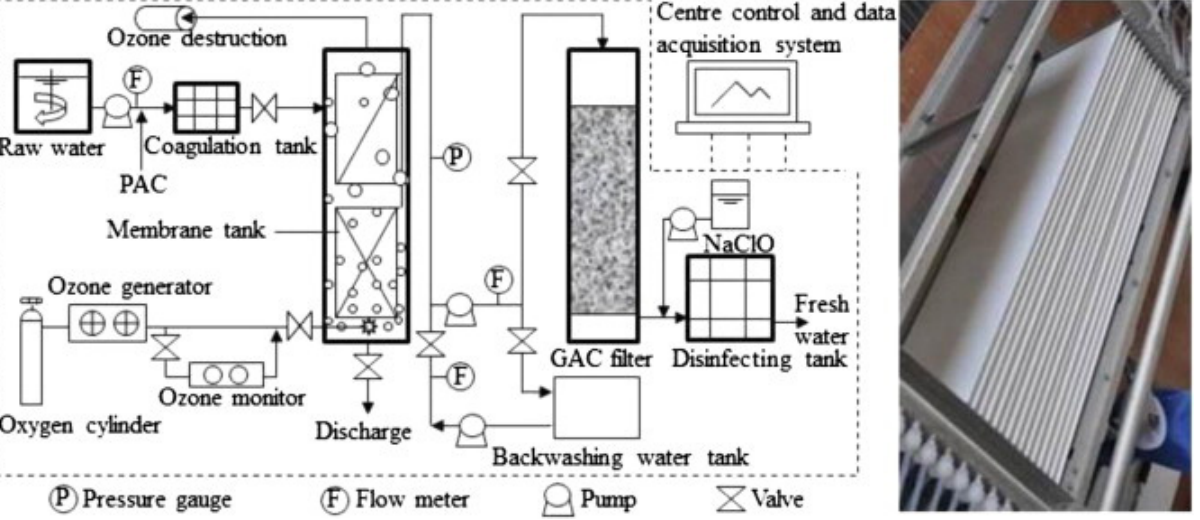
Figure 7. Schematic representation of the pilot-scale hybrid process for drinking water treatment. Reprinted from [91] with permission from Elsevier, 2014.